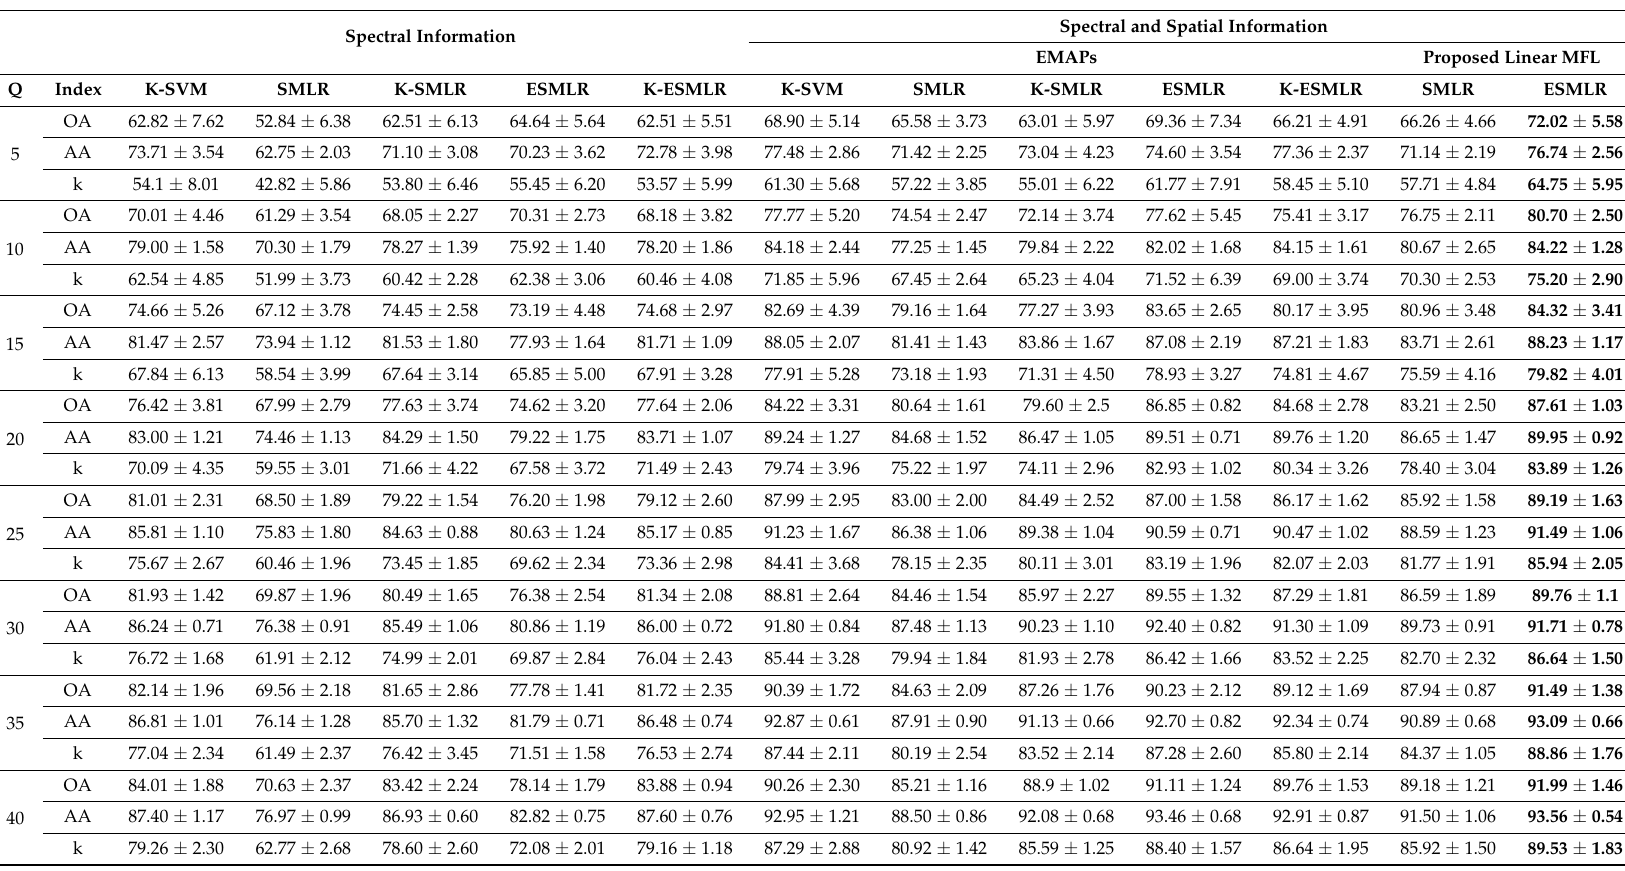
Table 4. Classification accuracy (%) with different numbers of labeled samples in Pavia University dataset (Best result of each row is marked in bold type). Spectral Information